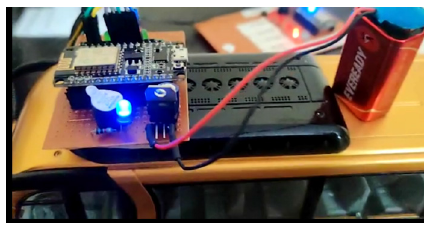
Figure 7. Installation of RFID Reader on each